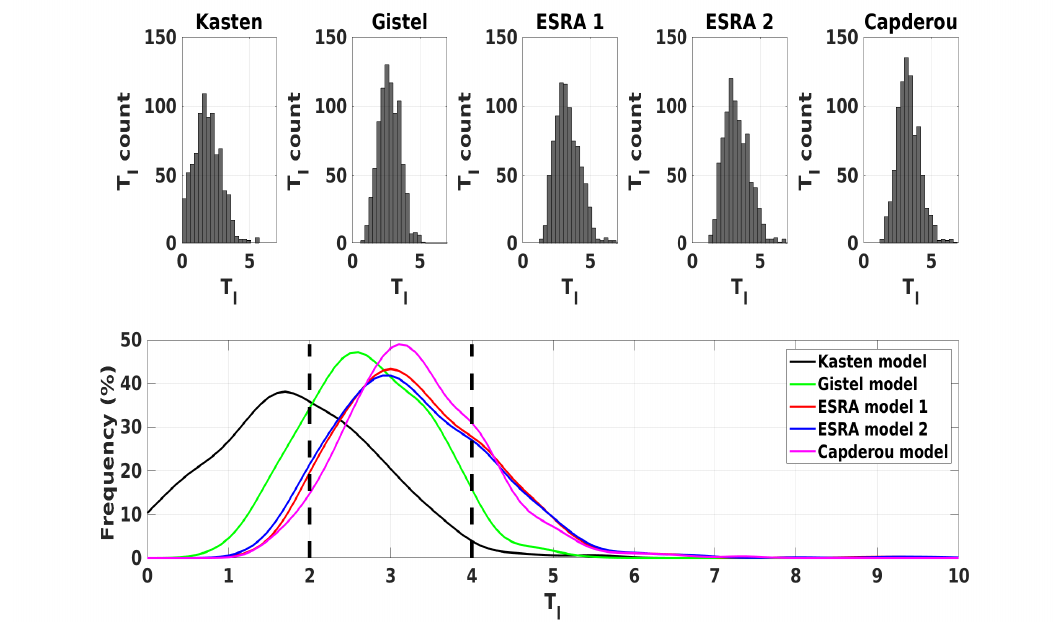
Figure 4. Histograms of Linke turbidity factor obtained with each model for the period